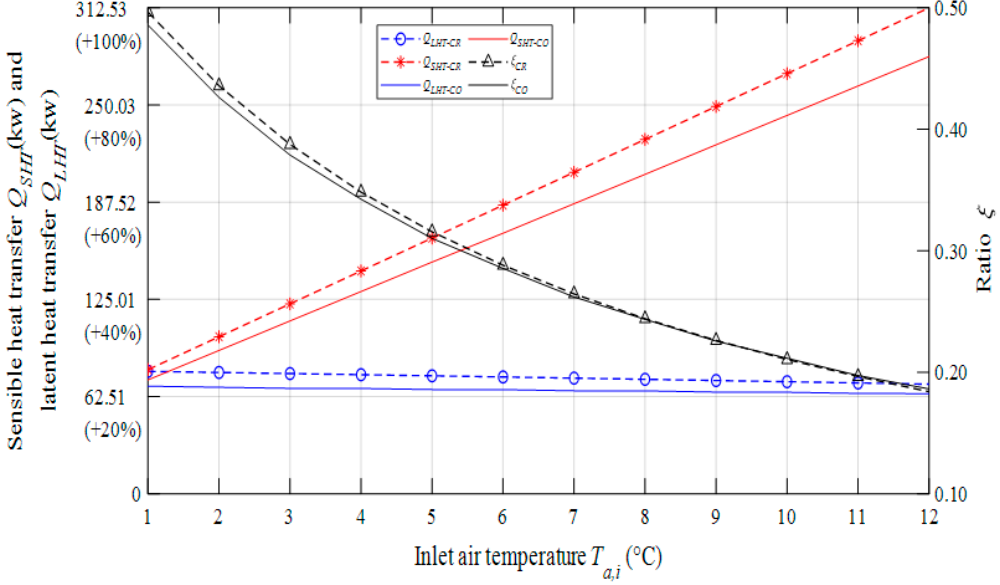
Figure 12. Influence of inlet air temperature on energy transfer characteristics.